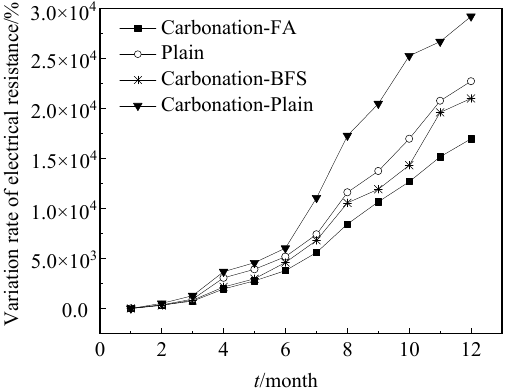
Figure 5. Electrical resistance-time curves of reinforcement cement paste.